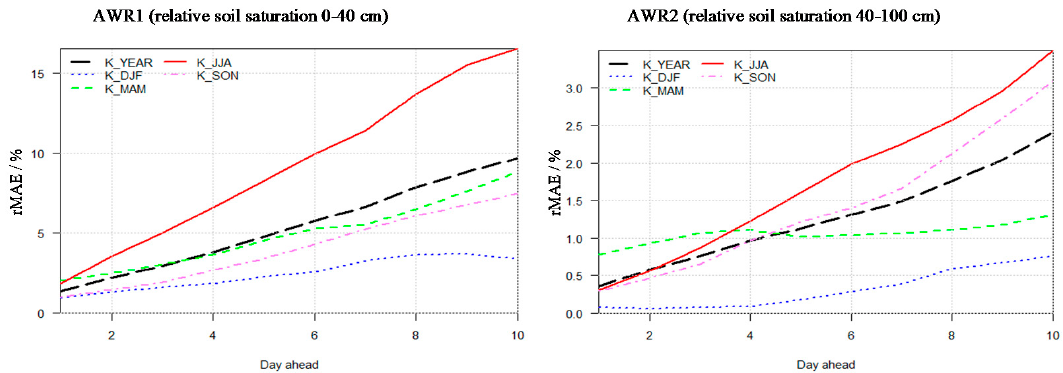
Figure 7. Relative MAE for IFS for individual seasons, upper soil profile ( left ) and deeper soil profile ( right ), for 10 days ahead (black line: YEAR, blue—DJF—winter, green—MAM—spring, red—JJA—summer, purple—SON—autumn).